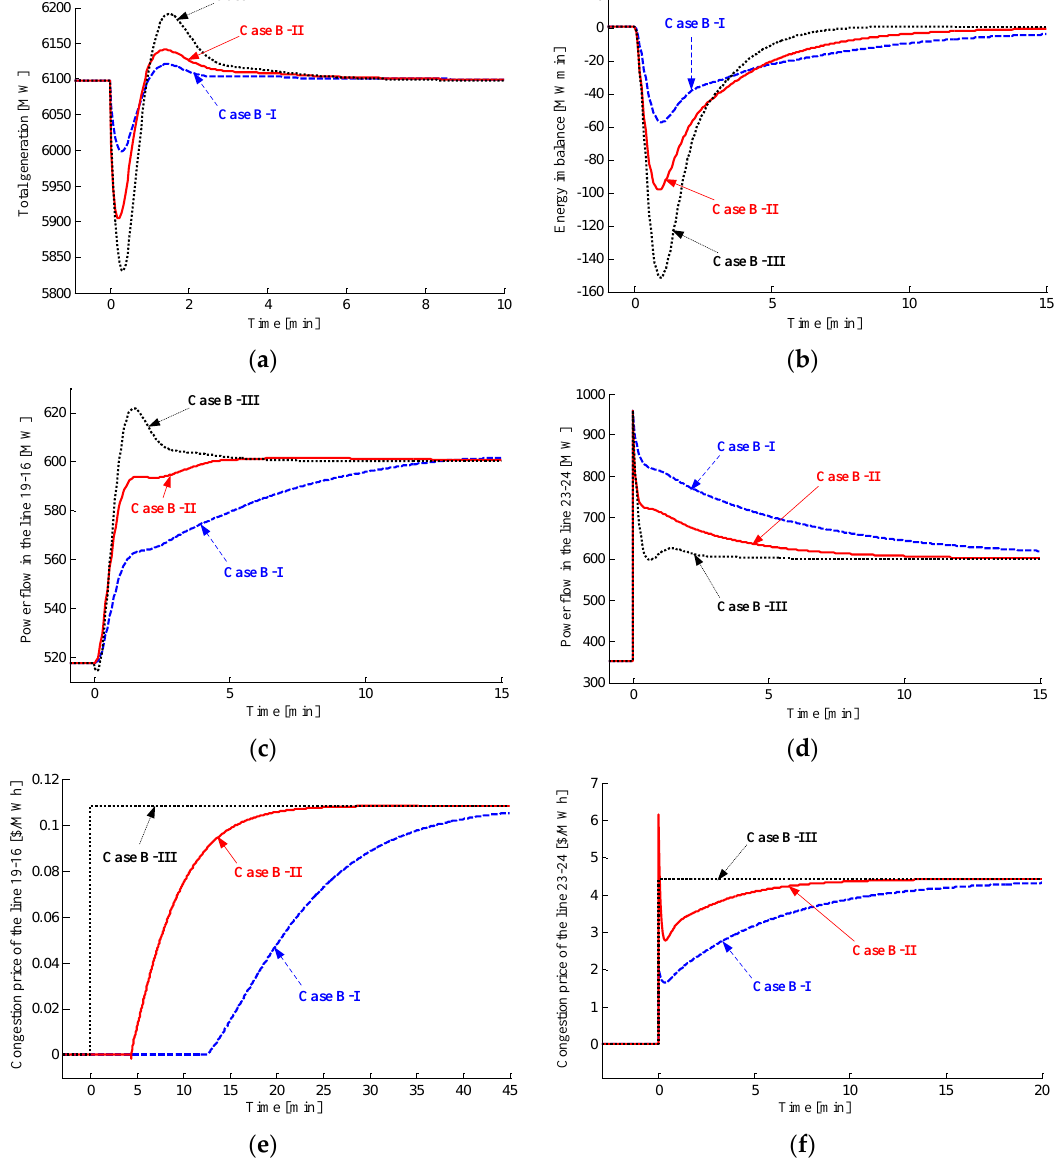
Figure 6. Simulation results for the line tripping scenario in the line from bus 21 to bus 22: ( a ) total amount of generation; ( b ) energy imbalance; ( c ) power flow in the line 19–16; ( d ) power flow in the line 23–24; ( e ) congestion prices of the line 19–16; and ( f ) congestion prices of the line 23–24.